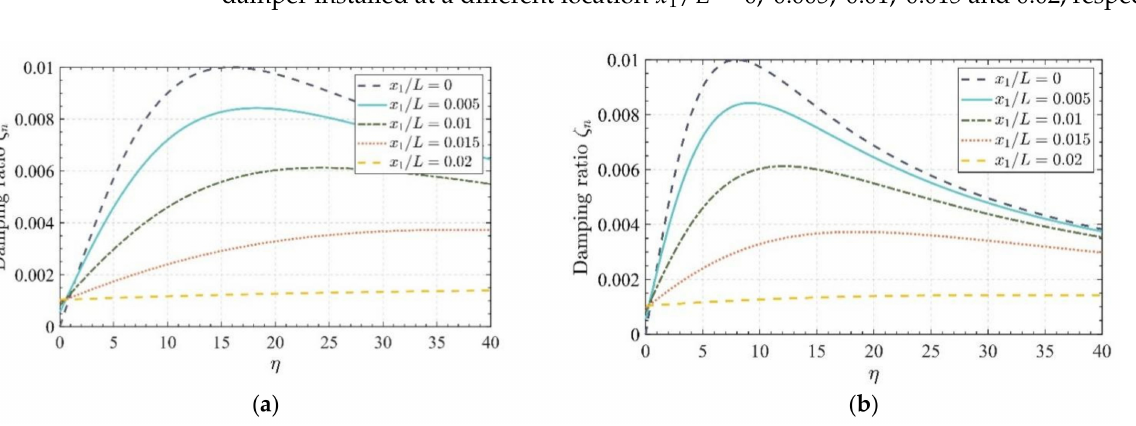
Figure 7. Impact of location of the internal rubber damper on cable modal damping with K = 300, k s = 0, ϕ = 0.5, x 2 / L = 0.02 and: ( a ) n = 1; ( b ) n =